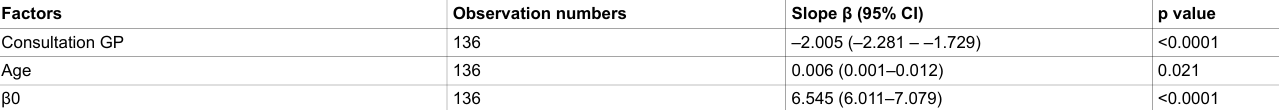
Table 4: Multiple regression analysis with logarithmic values, dependent variable consultation/waiting time of ENT cases only. The model explains 63% of the variability (R 2 0.63). Slope β: slope of the regression; 95% CI: 95% confidence interval of the regression’s slope. Non significant variables were not included in the table and were: sex (p = 0.95) and estimation of emergency (p =